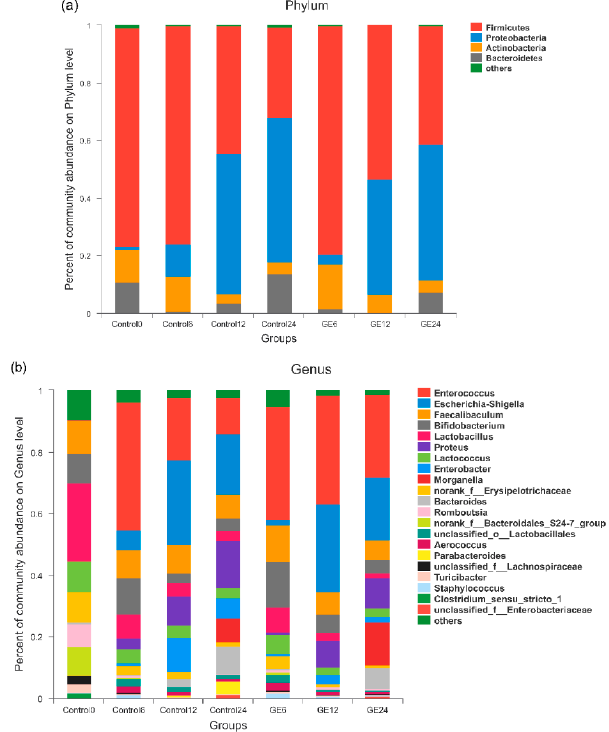
Figure 1. Relative abundance of the gut microbiota: ( a ) phylum level; and ( b ) genus level. Control0, Control6, Control12, and Control24 indicate fermentation of water at 0, 6, 12, and 24 h; GE6, GE12, and GE24 indicate fermentation of ginger extract (GE) at 6, 12, and 24 h.